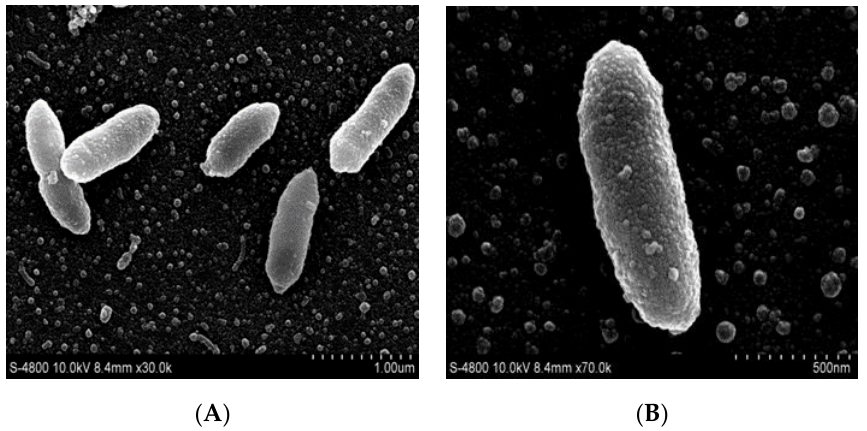
Figure 2. Morphological characterization of strain YL24-3 by scanning electron microscopy (SEM) (scale bar ( A ) = 1.0 µ m; ( B ) = 500